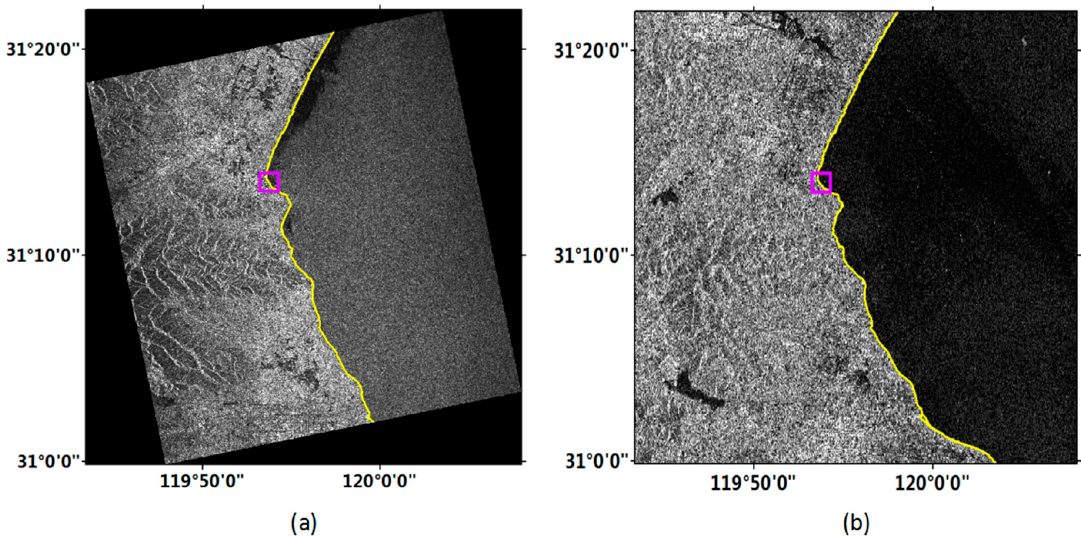
Figure 8. Coastline detection results from the improved FCM method in Taihu region. ( a ) Gaofen-3 image; ( b ) Sentinel-1 image. The box indicates the location of sub-region. Table 4. Quantitative evaluation in the sub-region B of Bohai.